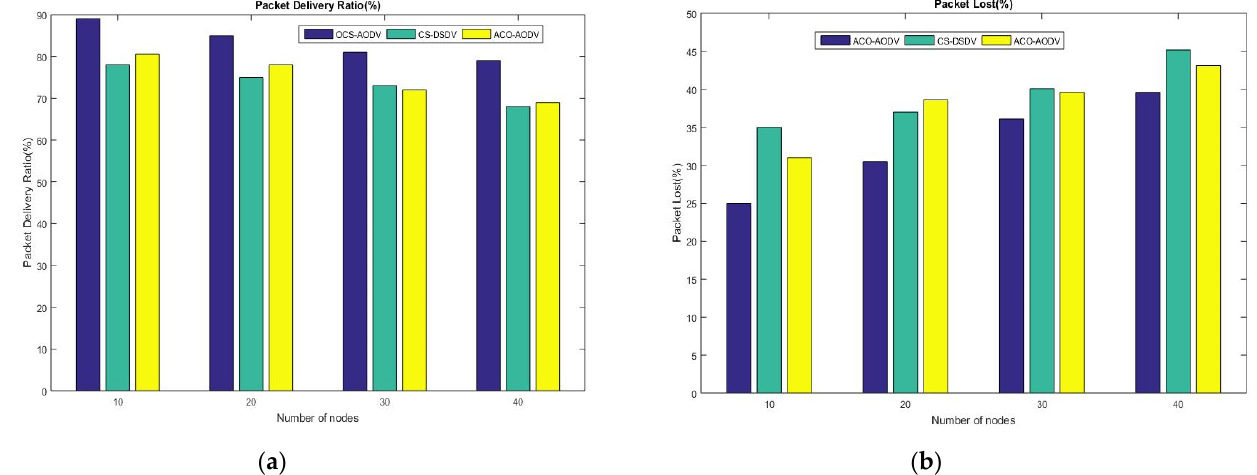
Figure 6. Packet Lost and Packet Delivery Ration Results for the three routing protocols: ( a ) The Packet delivery Ratios of the three Routing Protocols ( b ) Number of Packets Lost during the Simulation.